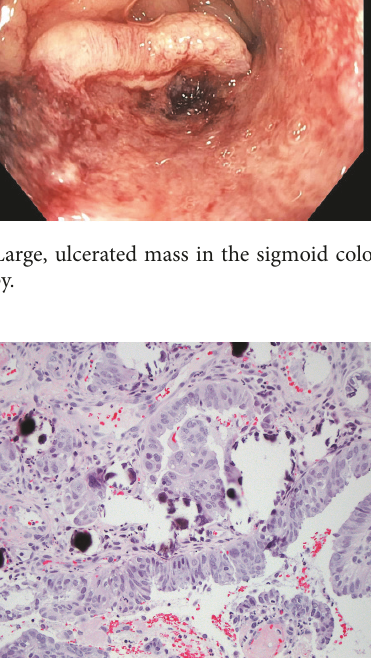
Figure 4: Normal colon mucosa on the left with the margin of tumor on the right containing large, atypical cells consistent with